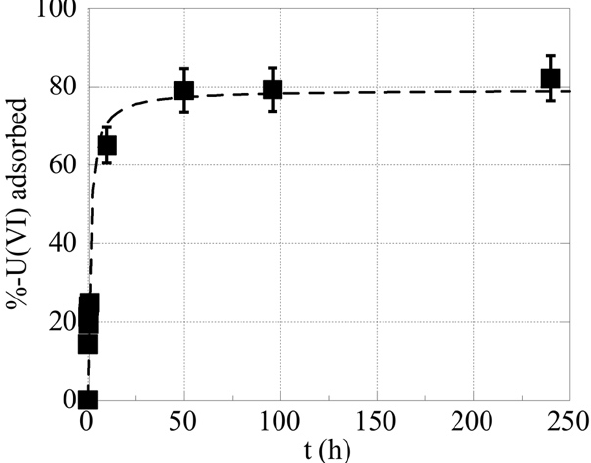
Figure 1. The %-relative amount of U(VI) adsorbed by oxidized biochar fibers (LCC_ox) as a function Figure 1. The % ‐ relative amount of U(VI) adsorbed by oxidized biochar fibers (LCC_ox) as a func ‐ of time. [U-232] = 8.6 × 10 − 14 mol/L, biochar mass = 0.01 g, pH 4 and ambient tion of time. [U ‐ 232] = 8.6 × 10 − 14 mol/L, biochar mass = 0.01 g, pH 4 and ambient conditions.